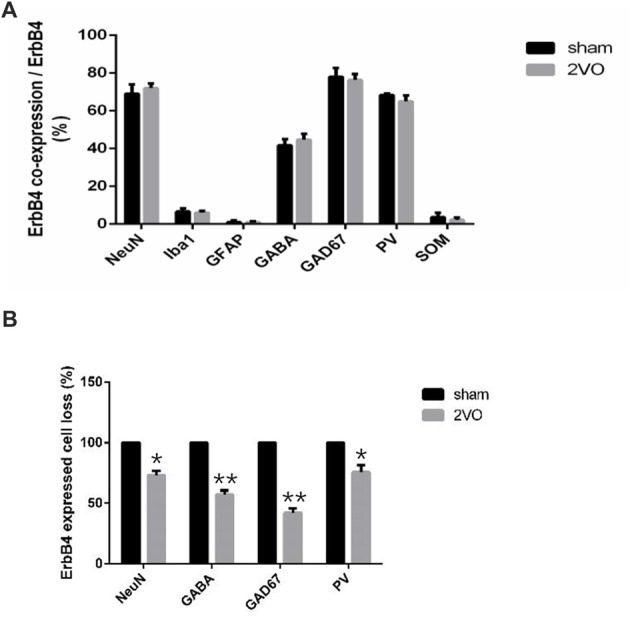
The distribution pattern of ErbB4 in the hippocampal CA1 subarea after CCH. (A) Comparison of the co-expression pattern of ErbB4 between the sham group and the 2VO group at 28 days. No significant difference was found between the two groups. (B) The quantification of ErbB4-expressed cell loss (NeuN, GABA, GAD67, PV) at 28 days. The value for the sham group was defined as 100%. Data are expressed as mean ± SEM. Comparisons in the two groups (n = 6 for each group) were analyzed by Student’s t-test. *p < 0.05, **p < 0.01 vs. sham group.